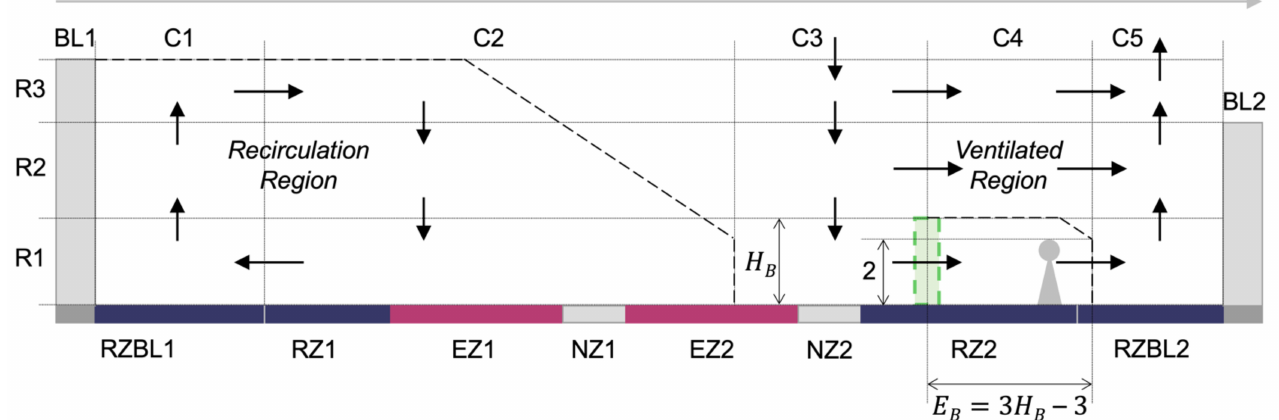
Figure 3. Model grid adopted to represent our example street section when the wind aloft blows from left to right, comprising five columns (C1–5) and three rows (R1–3). The dashed green rectangle illustrates the position of a proposed barrier (specified by the user) of height, H B , altering the flow of air around a partially isolated region in its immediate wake; the extent of this region, E B , is calculated according to Equation (2) to enclose a person up to 2 m tall. The black arrows indicate the directions (but not the magnitudes) of the advection velocities used to model the flow of air without the barrier, and modified in response to the